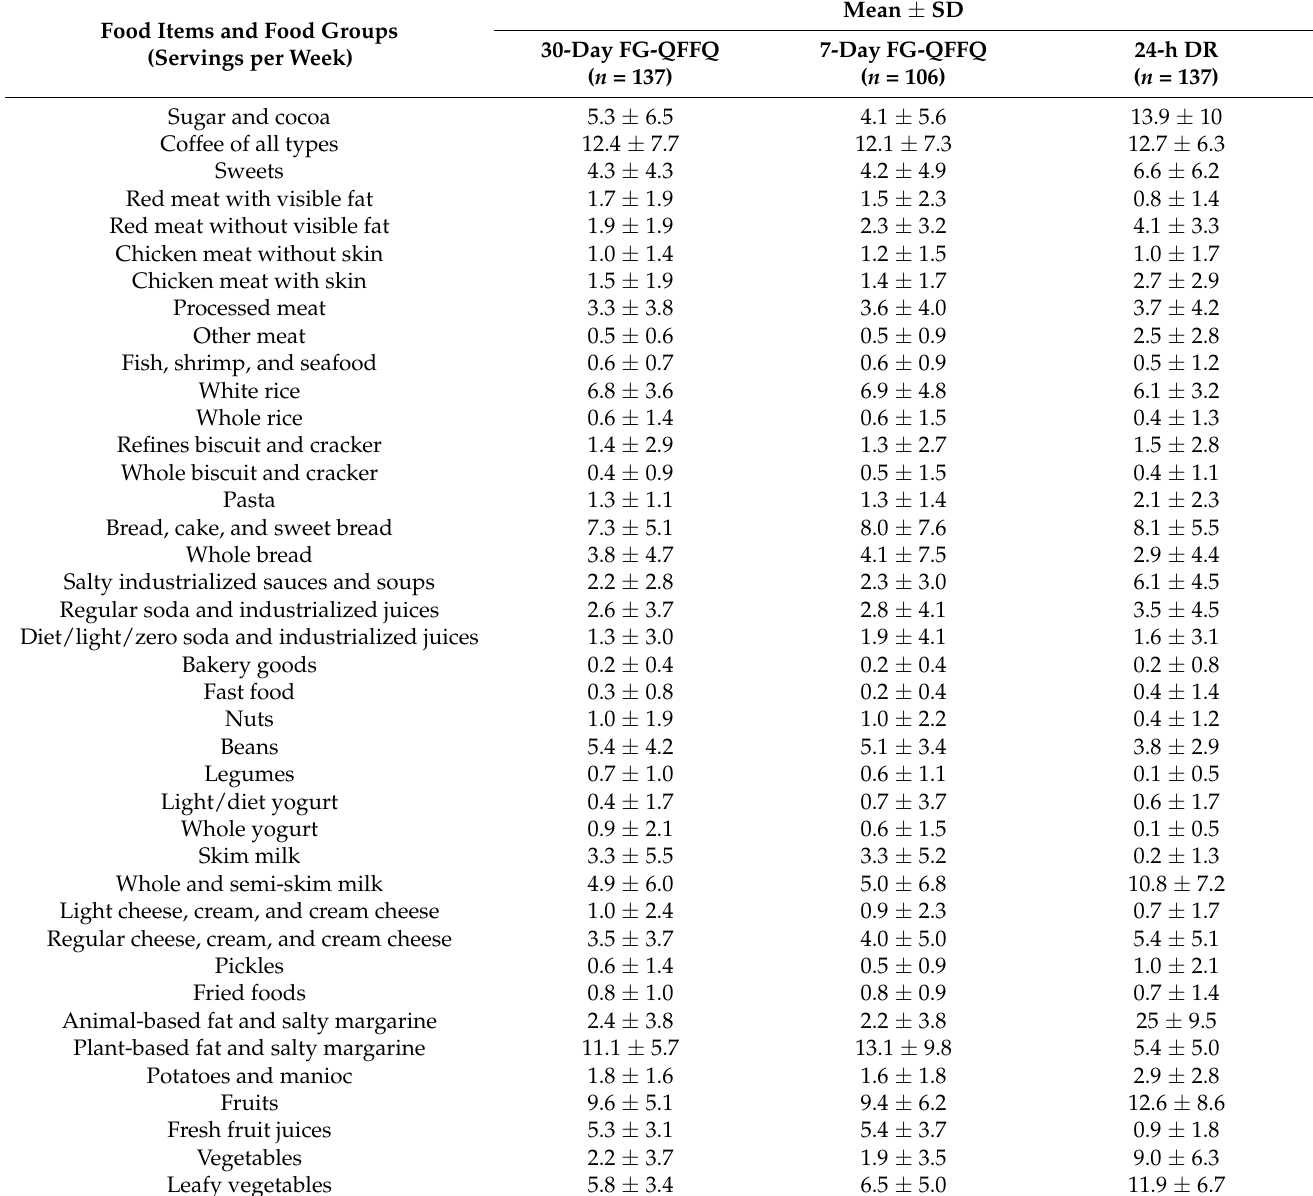
Table 3. The mean and standard deviation of food items and food groups intake assessed using the 30-day FG-QFFQ, the 7-day FG-QFFQ, and the 24-h dietary